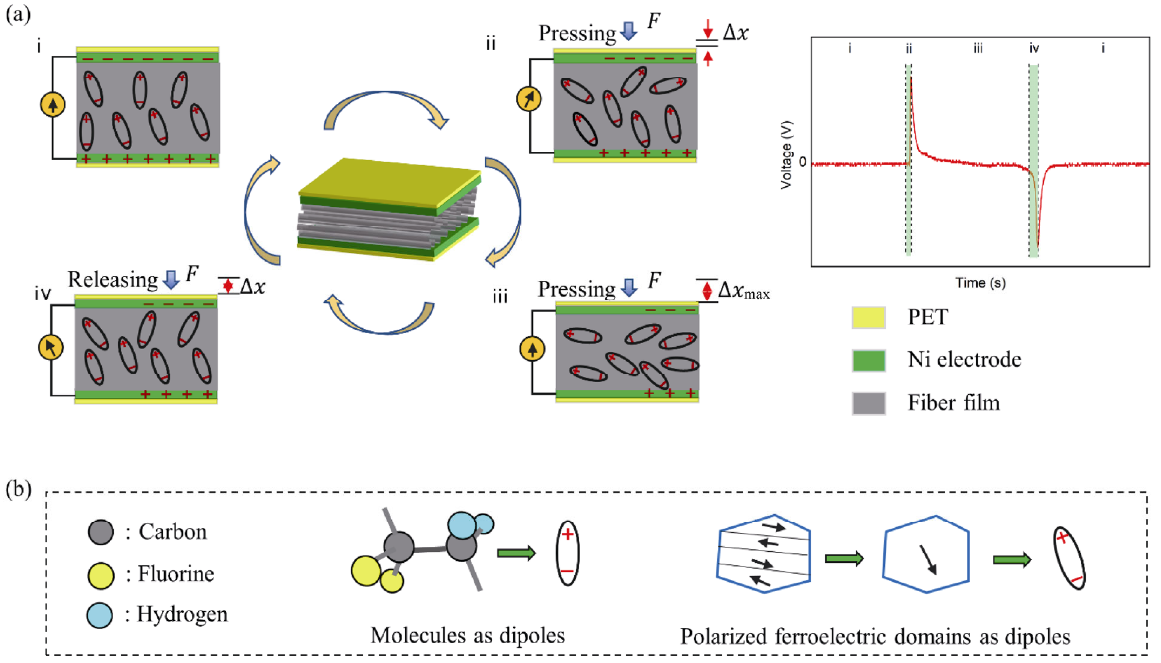
Fig. 6 (a) Schematic diagram of the mechanism for the piezoelectric performance of PZT/PVDF fiber-based PENGs and (b) abstract diagram of the dipoles about PVDF molecules and PZT ferroelectric domains inside the fibers. Fig. 6(b). All the dipoles align in the same